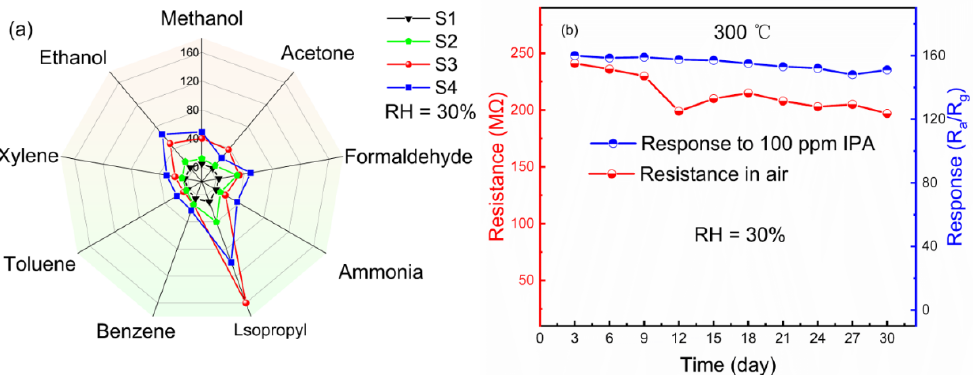
Figure 6. Selectivity of the four samples measured at 300 °C ( a ); long-term stability of S3 toward 100 ppm IPA at 300 °C ( b ).